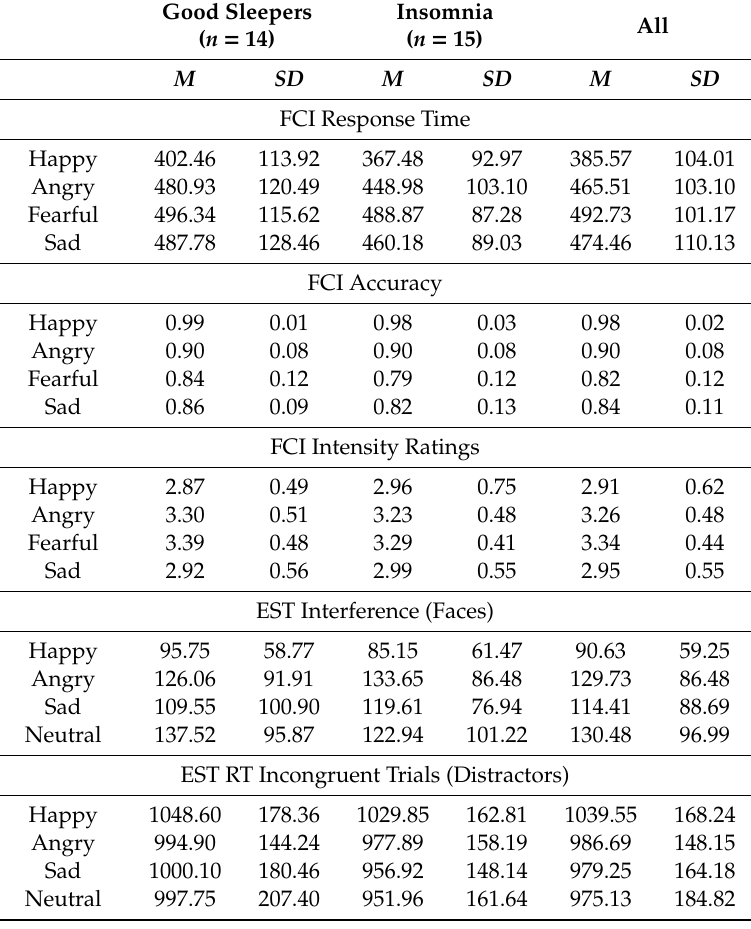
Table 4. Means and standard deviations for measures from the Face Categorization and Intensity Rating Task (FCI) and the Face-word Emotion Stroop Task